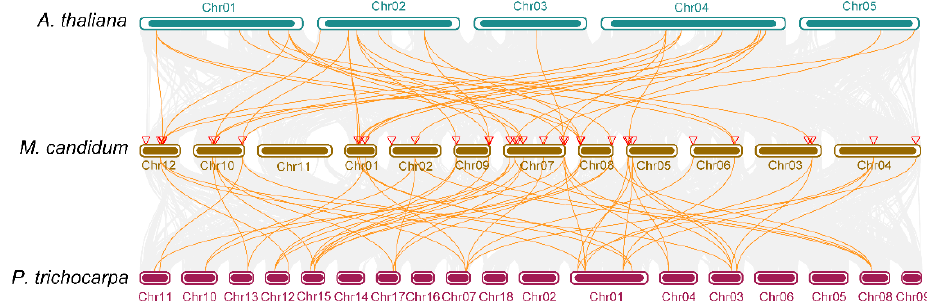
Figure 8. Multi-collinearity analysis of three species. The orange lines between two species denote collinearity genes among different species.